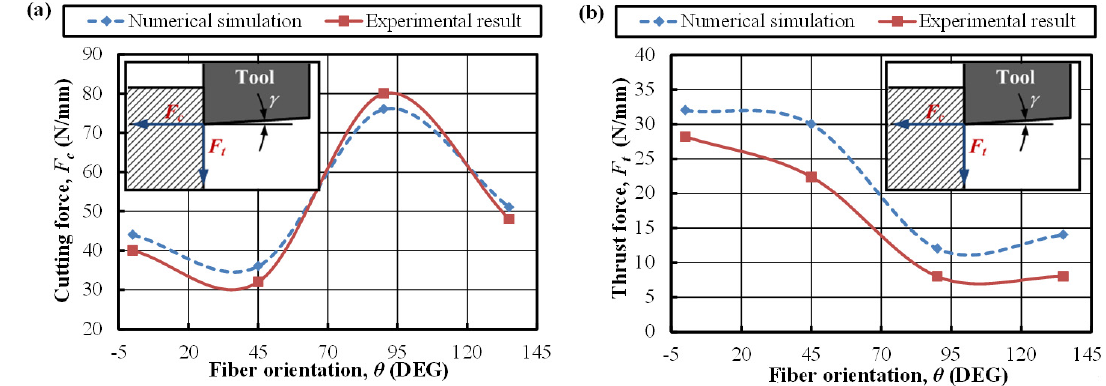
Figure 5. Comparison of the simulated and experimental force generations in CFRP-phase cutting modeling [28]: ( a ) cutting force; ( b ) thrust force (cutting condition: v c = 6 m/min, f = 0.2 mm, α = 0°).